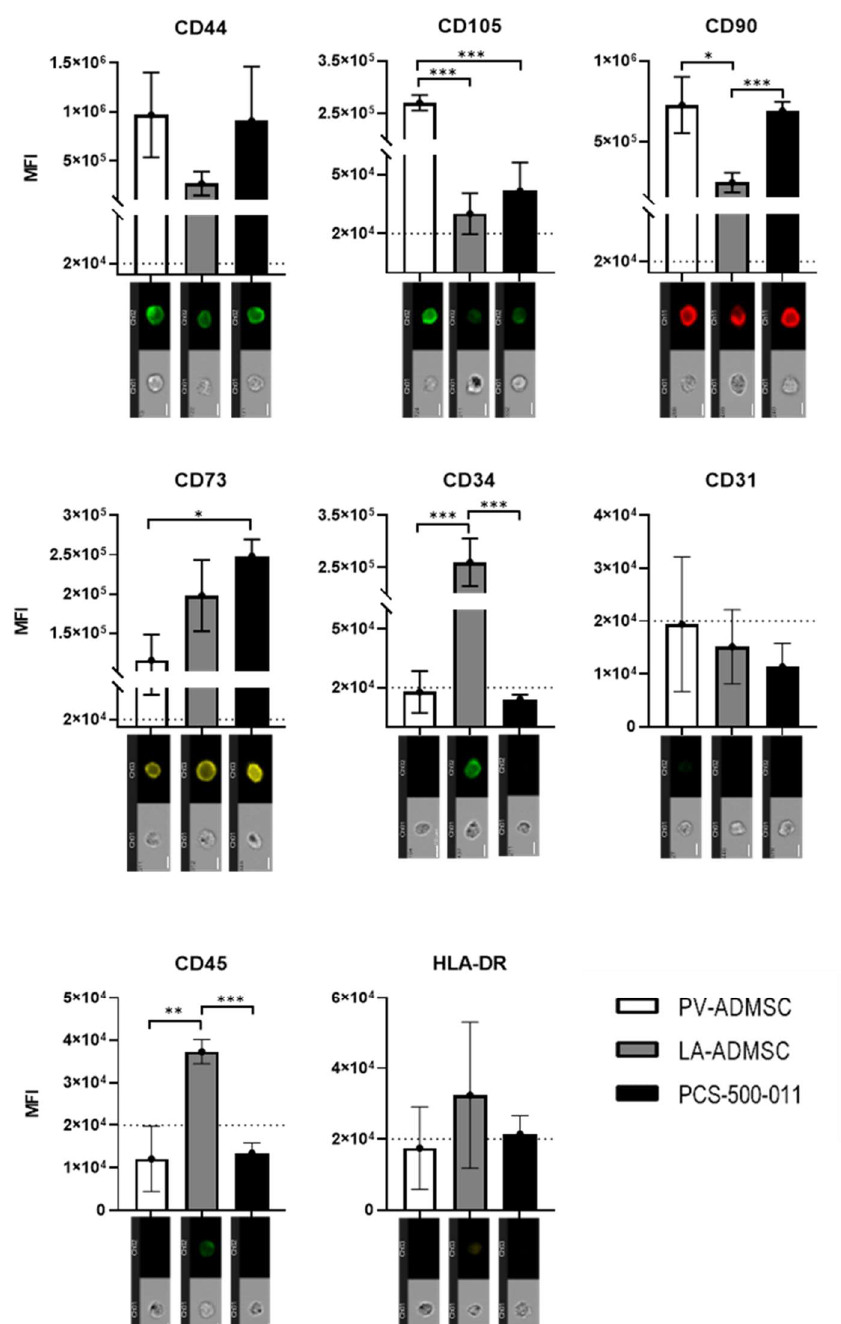
Figure 3. MSC protein marker analysis by imaging flow cytometry. Cells were cultured in MSCBM, harvested at passages 2, 3 and 4, and fixed. Monoclonal antibodies conjugated to FITC (CD44, CD105), AF488 (CD31, CD34, CD45), PE (CD73, HLA-DR) and APC (CD90) were used to stain the cells. One thousand events were analysed for cell type and protein markers. Values are expressed as median fluorescence intensity (MFI), with error bars representing the mean ± S.D. of three independent samples (p2-p4). Differences between the cells: * p < 0.05, ** p < 0.01, *** p < 0.001 were calculated using ANOVA. Representative images are shown below each bar (scale = 10 µm). The dashed line represents a threshold of 2 × 10 4 MFI above which the signal was considered positive. Regarding the negative markers, LA-ADMSC had the highest values for negative markers compared to PV-AMDSC and PCS-500-001. While no significant differences were found for CD31 and HLA-DR, the expression of CD45 was above the threshold and